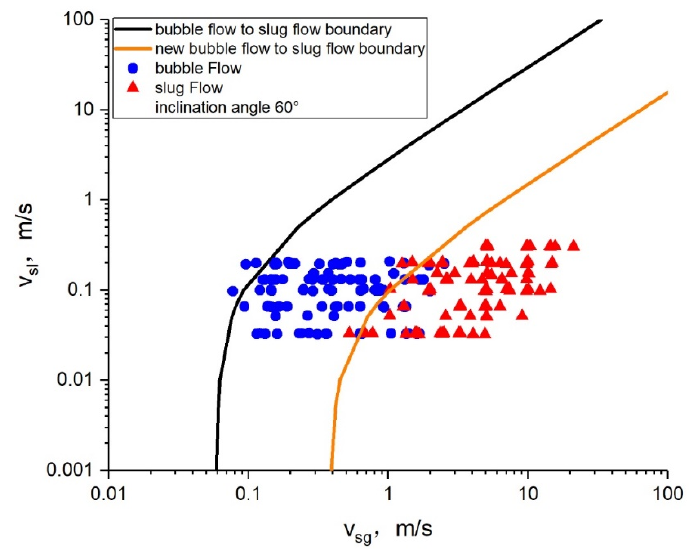
Figure 6. The boundary for discriminating the transition from bubbly flow to slug flow.